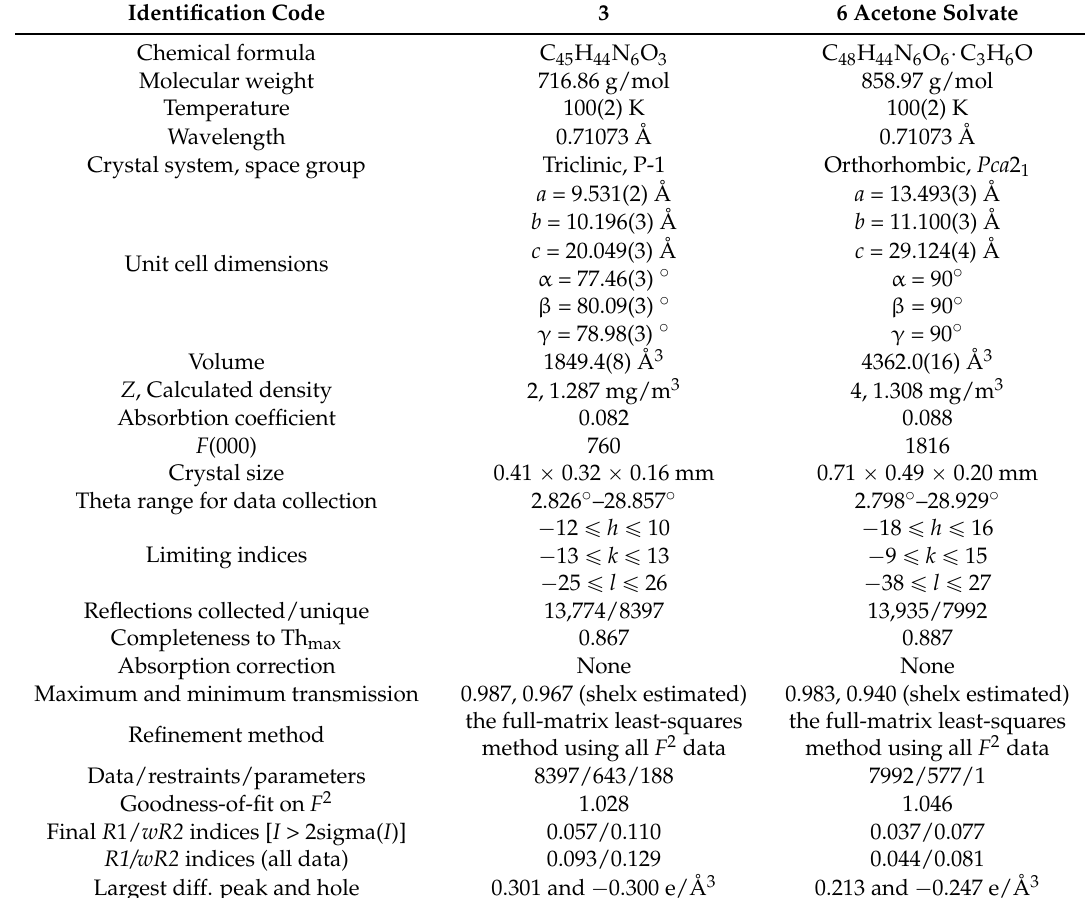
Table 5. Summary of crystallographic data and structure refinement for 3 and 6 acetone